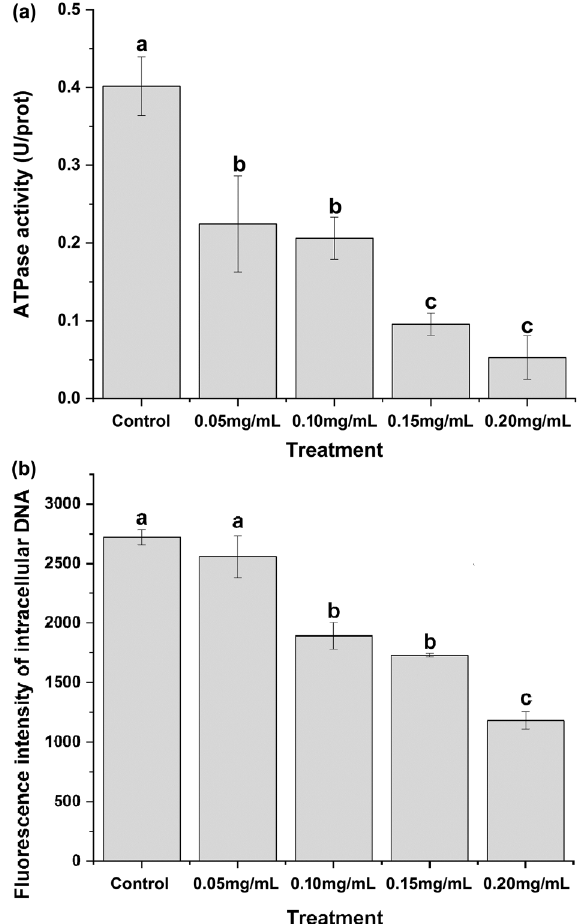
Fig. 4: Effects of bioassay-guided fraction from Athyrium sinense (PA) on intracellular ATPase activity and DNA content in Clavibacter michiganensis subsp. sepedonicus (Cms). Control was Cms cells treated with 0.80% DMSO. Data were expressed as the mean of three technical replicates (three tests using the same extract) ± standard deviation. Different letters represented significant differences ( P